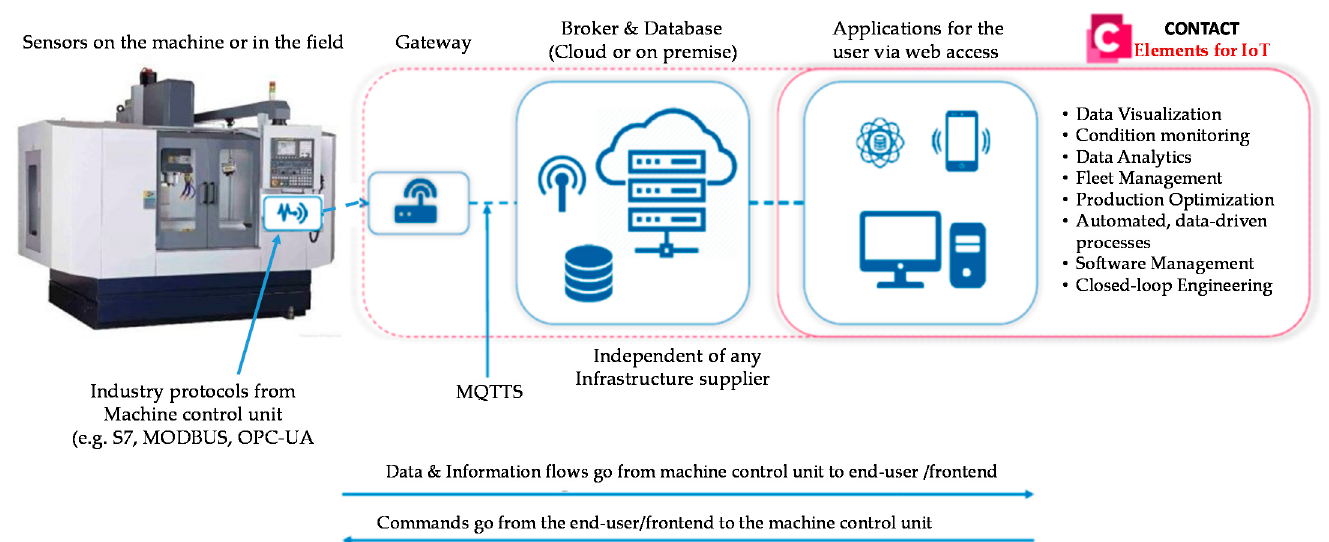
Figure 1. The schematic diagram of the infrastructure of Internet of Things (IoT) processing.